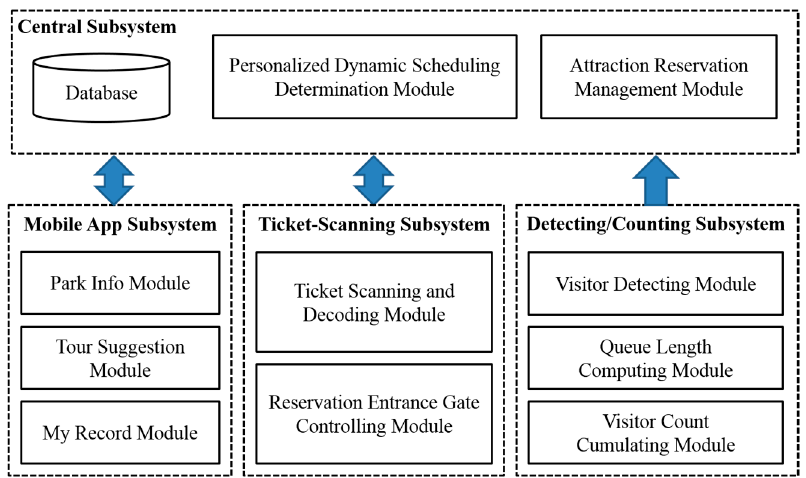
Figure 2. The TPTS system architecture.